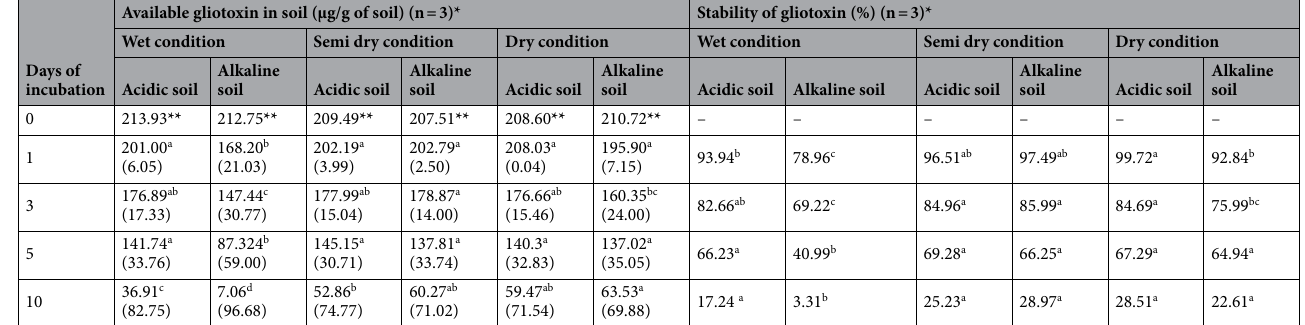
Table 4. Stability of gliotoxin in sterile soil. In each row, the mean values followed by a common letter or ** are not significantly different (p ≤ 0.05). Statistical analysis was carried out separately for available gliotoxin and stability of gliotoxin. Values in the parentheses are percent degradation of gliotoxin. *Values are means of three